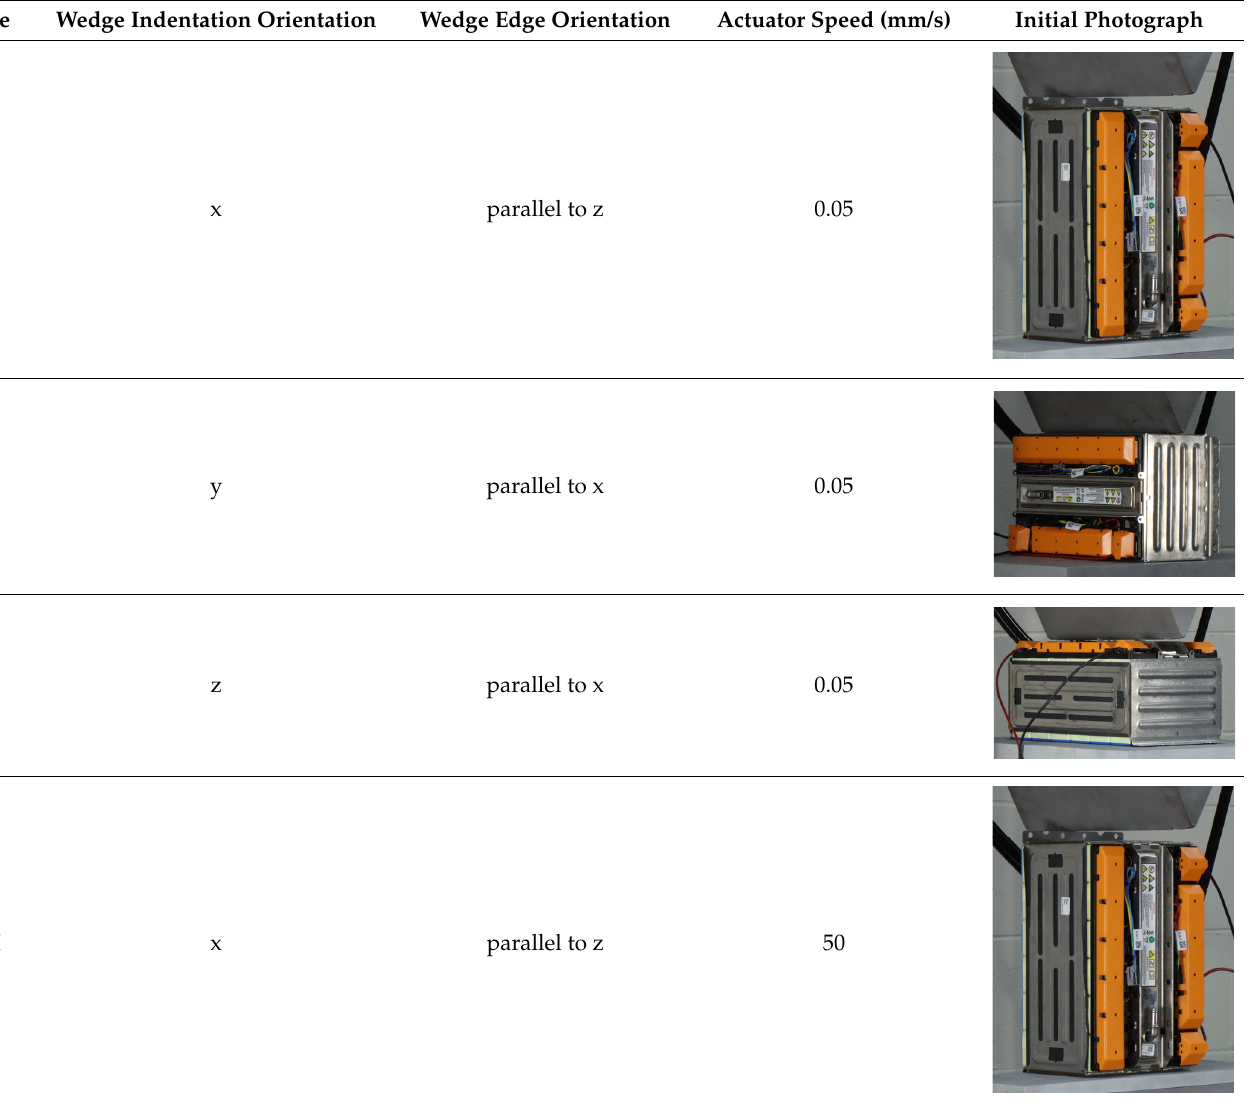
Table 1. Wedge indentation direction, wedge edge orientation, and actuator speed details.